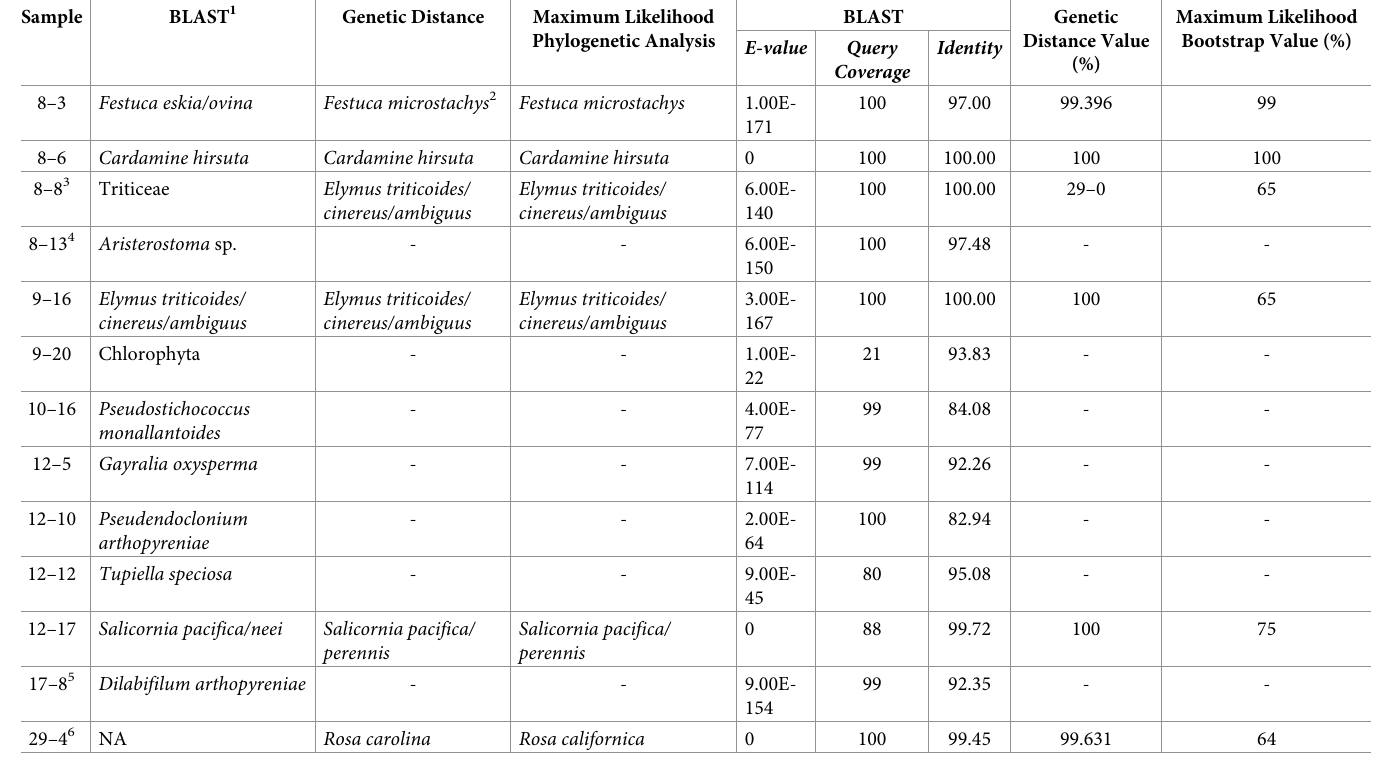
Table 2. Taxonomic identifications of